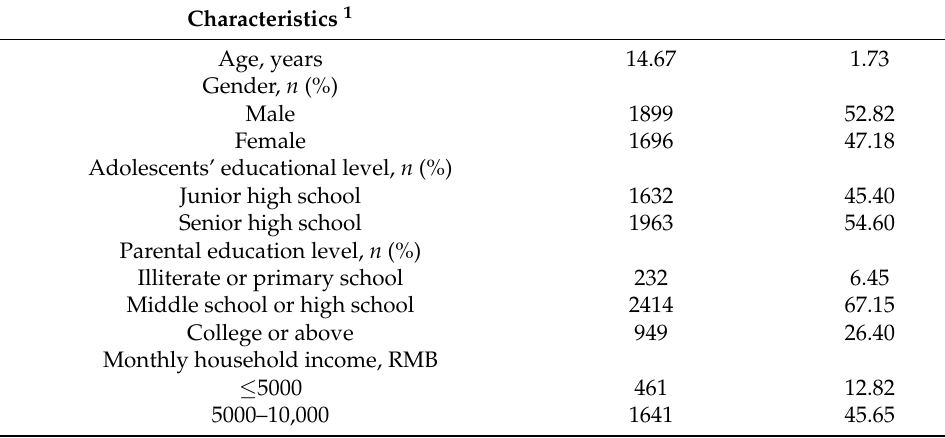
Table 1. Baseline characteristic of